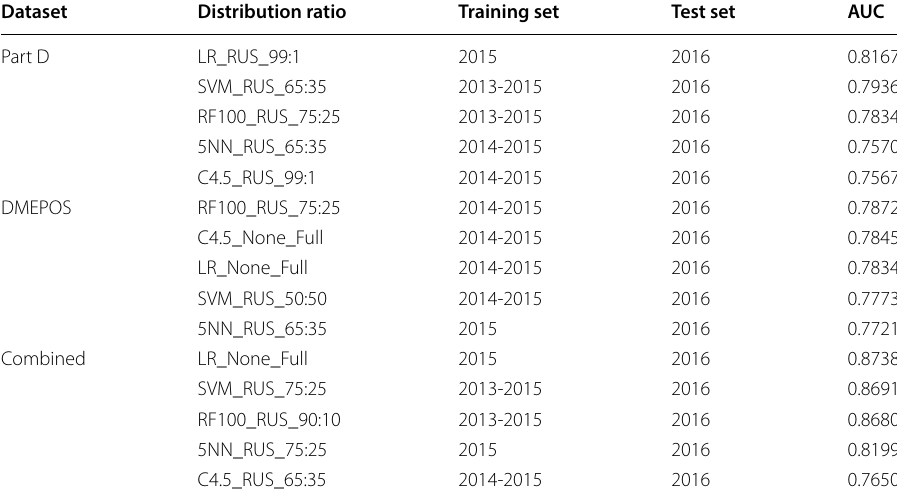
Table 5 AUC summary Dataset Distribution ratio Training set Test set